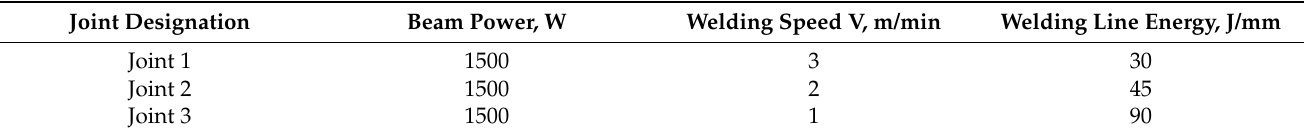
Table 3. Parameters of the welding process of test joints.